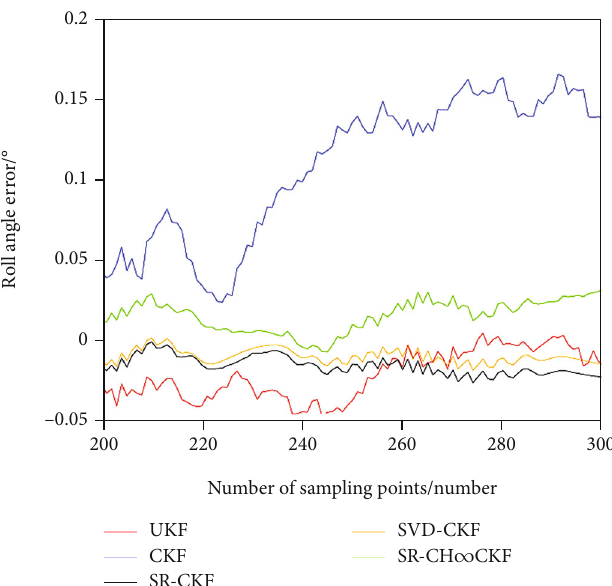
Figure 8: Comparison diagram of roll angle error within 200 ~